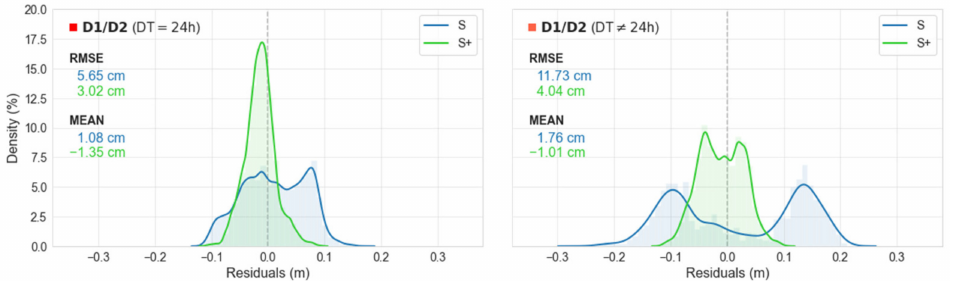
Figure 11. Density distribution of inter-day crossover residuals ( DH RES ) for the 2 different config- urations: S (blue) and S+ (green). The left panel distribution corresponds to crossover residuals associated to a 24 h return period, and the right panel displays the